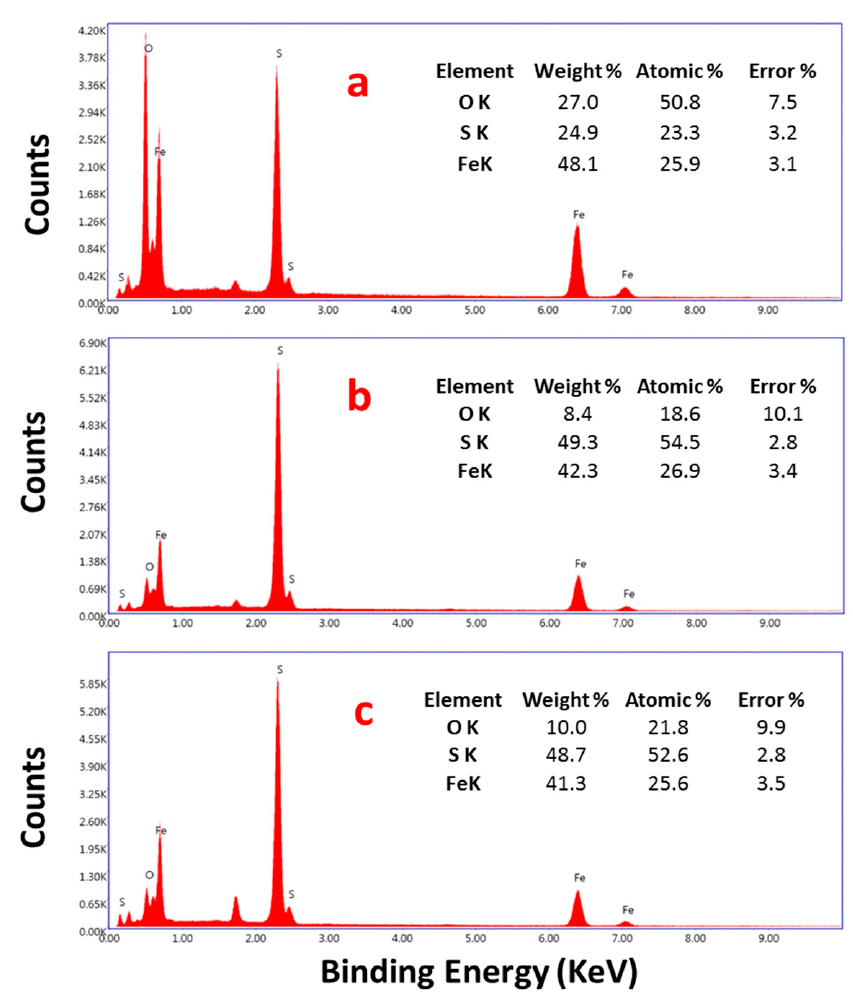
Figure 6. Energy-dispersive X-ray spectrum of the as-synthesized pyrite nanocrystals at 24 h with different concentrations of thiourea as the sulfur source: ( a ) 40 mmol/L, ( b ) 80 mmol/L, and ( c ) 160 mmol/L.